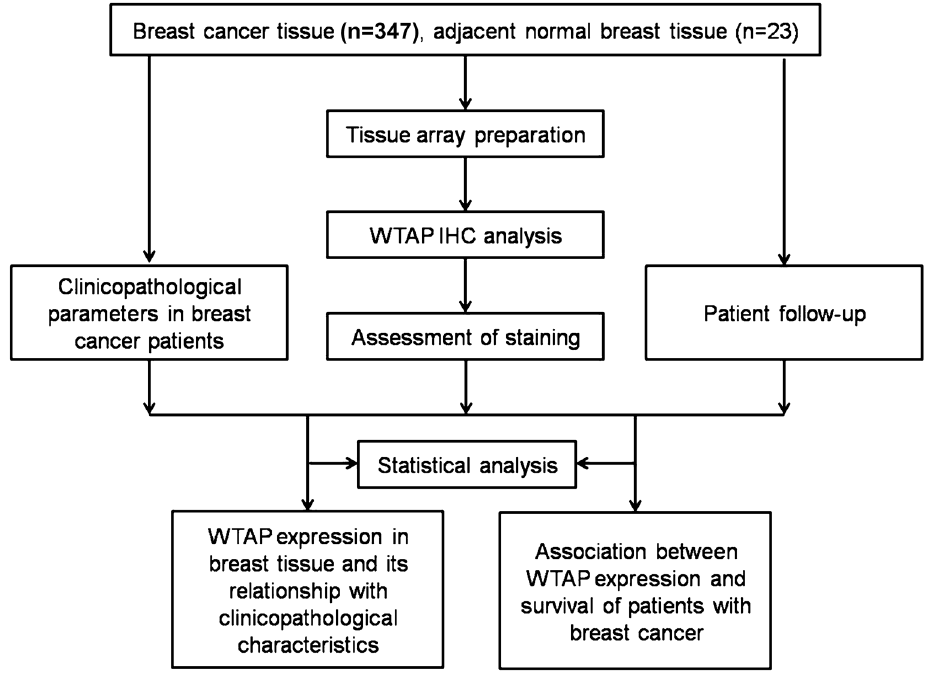
Figure 3. Flow diagram of the study